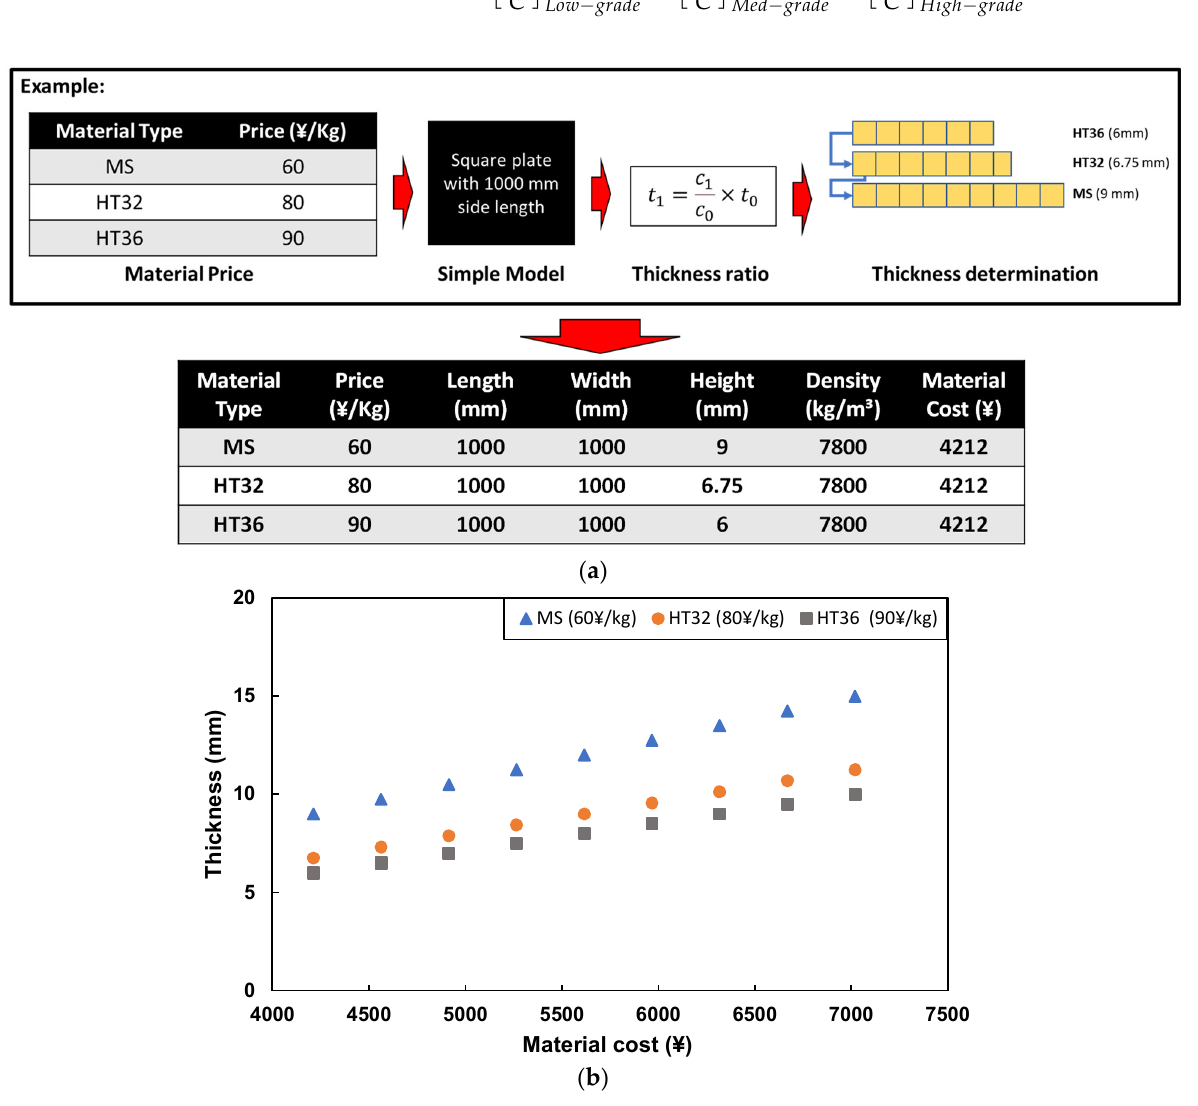
Figure 4. ( a ) Thickness determination based on price; ( b ) Thickness ratio.